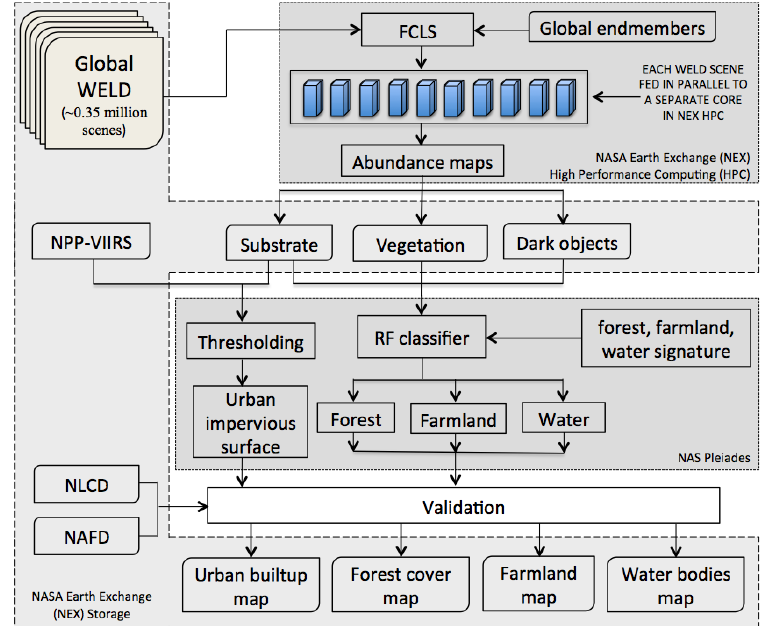
Figure 3. Overall methodology of classification.